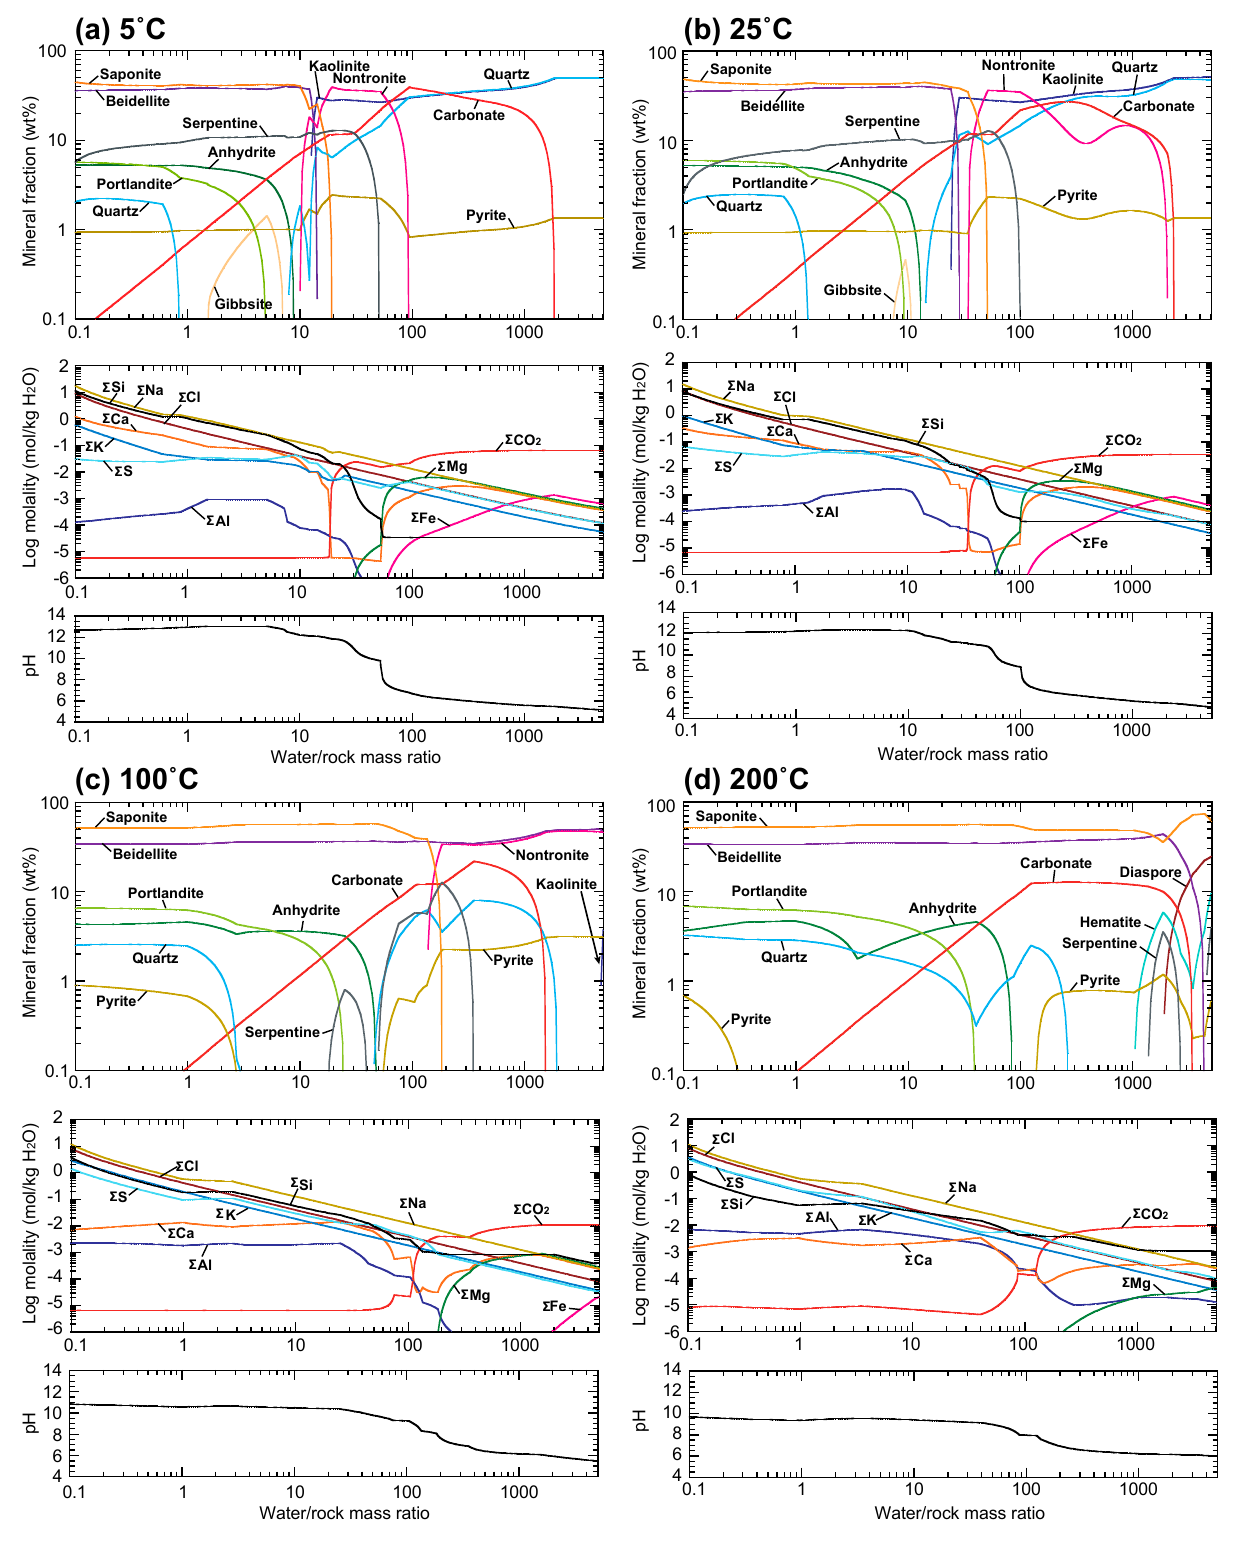
Figure 2. Secondary mineral assemblage, ion concentrations in groundwater, and pH as a function of water-to-mass ratio (W/R) when rock reacted with O 2 -bearing initial fluid (Case I-SG) at temperatures of ( a ) 5 °C; ( b ) 25 °C; ( c ) 100 °C; and ( d ) 200 °C. Gas fugacities were not fixed during water–rock reactions.